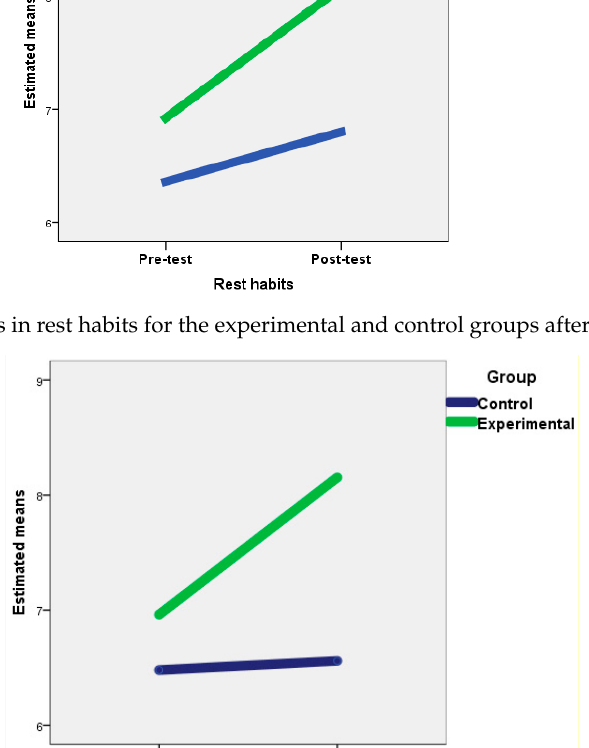
Figure 2. Changes in balanced diet for the experimental and control groups after the intervention.